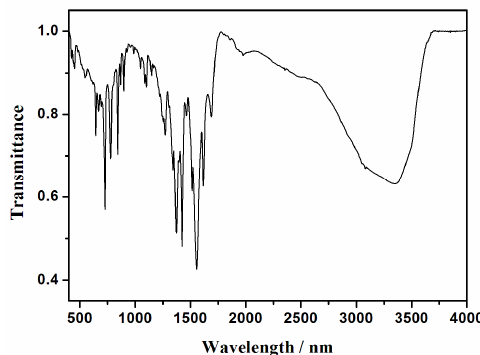
Figure 4. The IR spectra of the complex 1 .